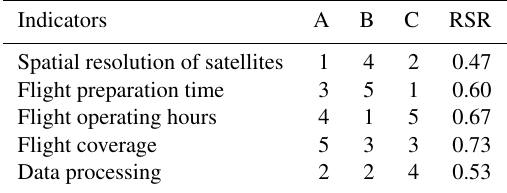
Table 4. Indicator rank and RSR.